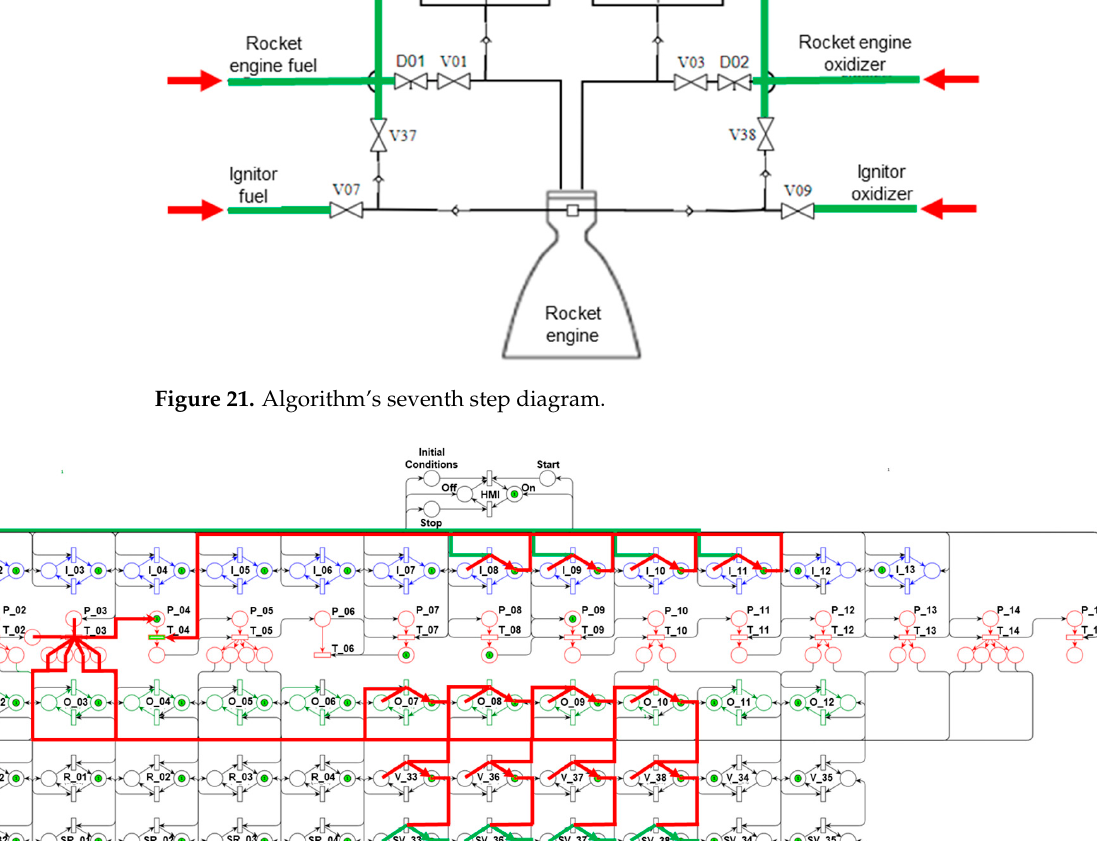
Figure 21. Algorithm’s seventh step diagram.